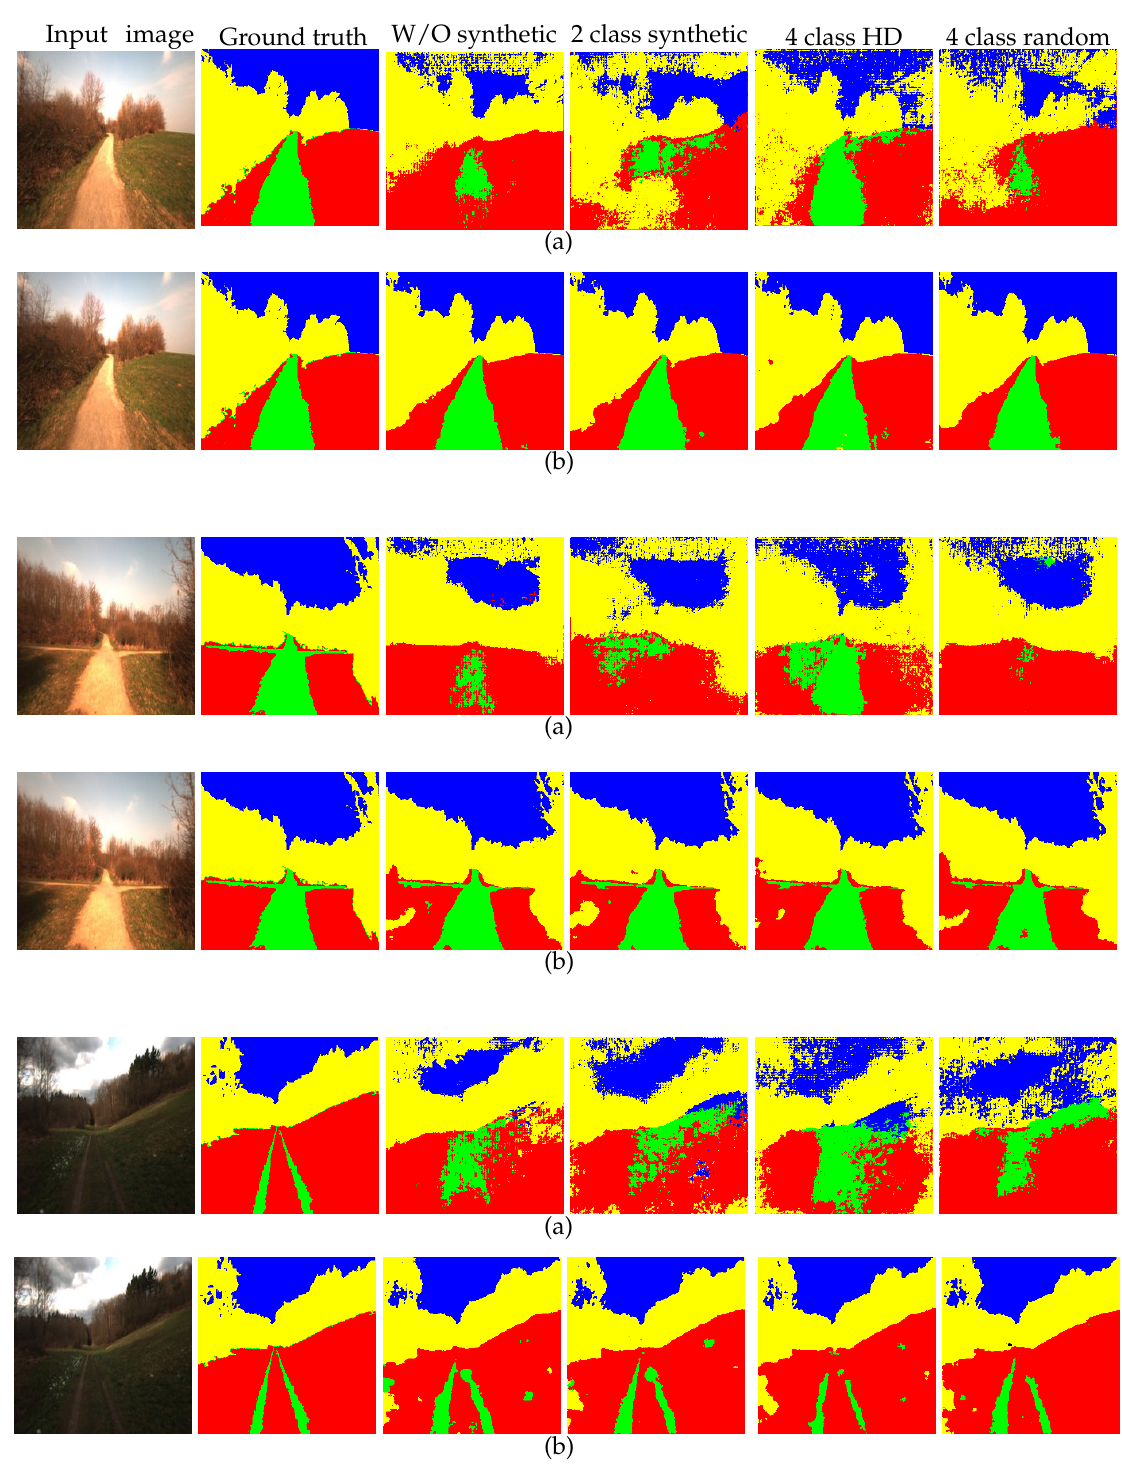
Figure 10. Examples to show that the light-weight network produces better results than DeconvNet for each of the experiments. Note that each pair of rows ( a , b ) represents the results produced by DeconvNet and the proposed light-weight network, respectively. Best viewed in